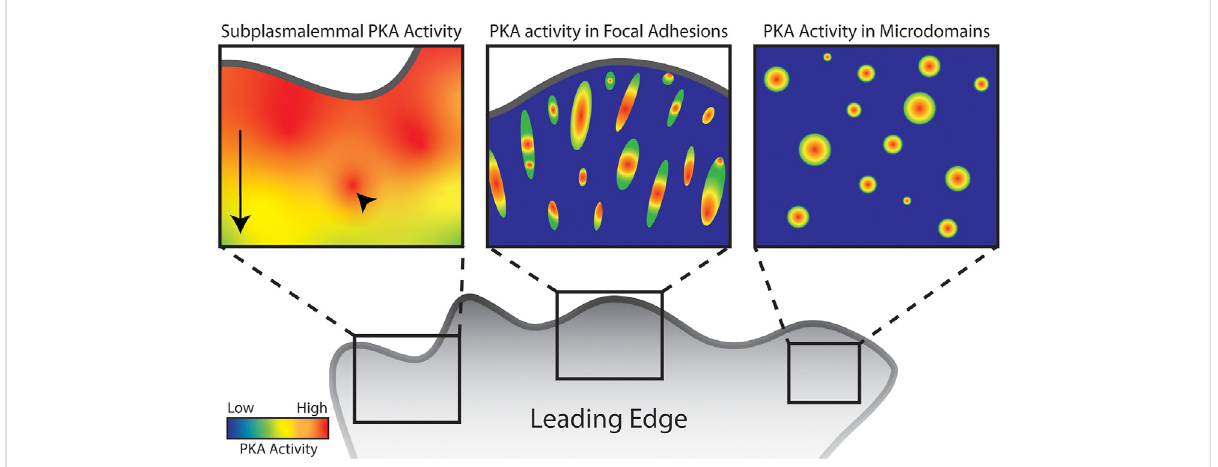
FIGURE 1 Schematic of PKA activity localized to distinct subcellular regions and structures in a migrating cell. Arrow highlights overall front to back gradient of subplasmalemmal PKA activity in the leading edge while arrowhead highlights hotspots of PKA activity.Though leading edge PKA activity has been well characterized, there are very few studies characterizing PKA activity in focal adhesions and microdomains. Images serve as representation of the concentration of PKA activity in these